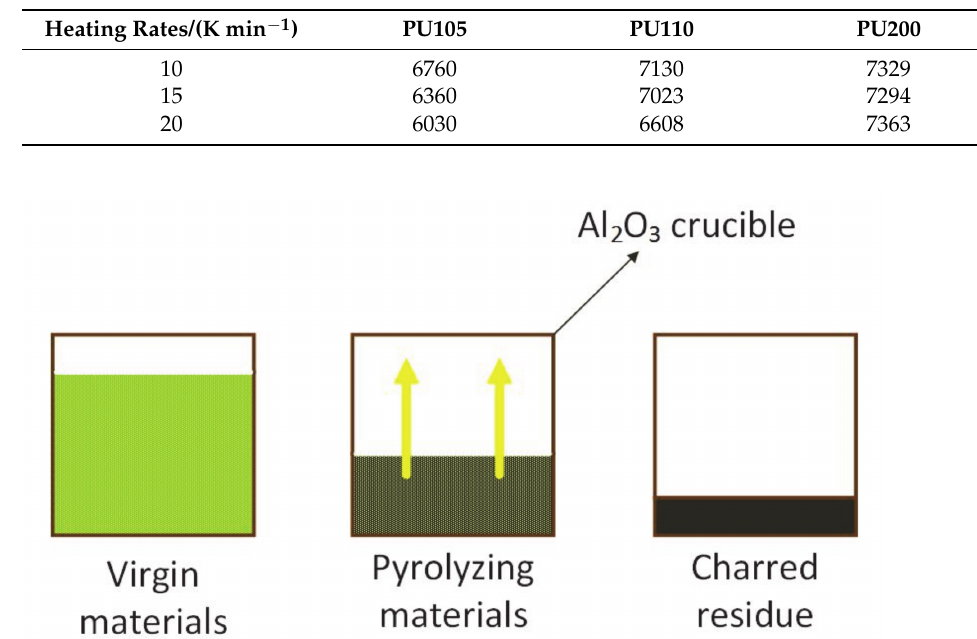
Table 5. Heat release during DSC testing kW m − 2 .